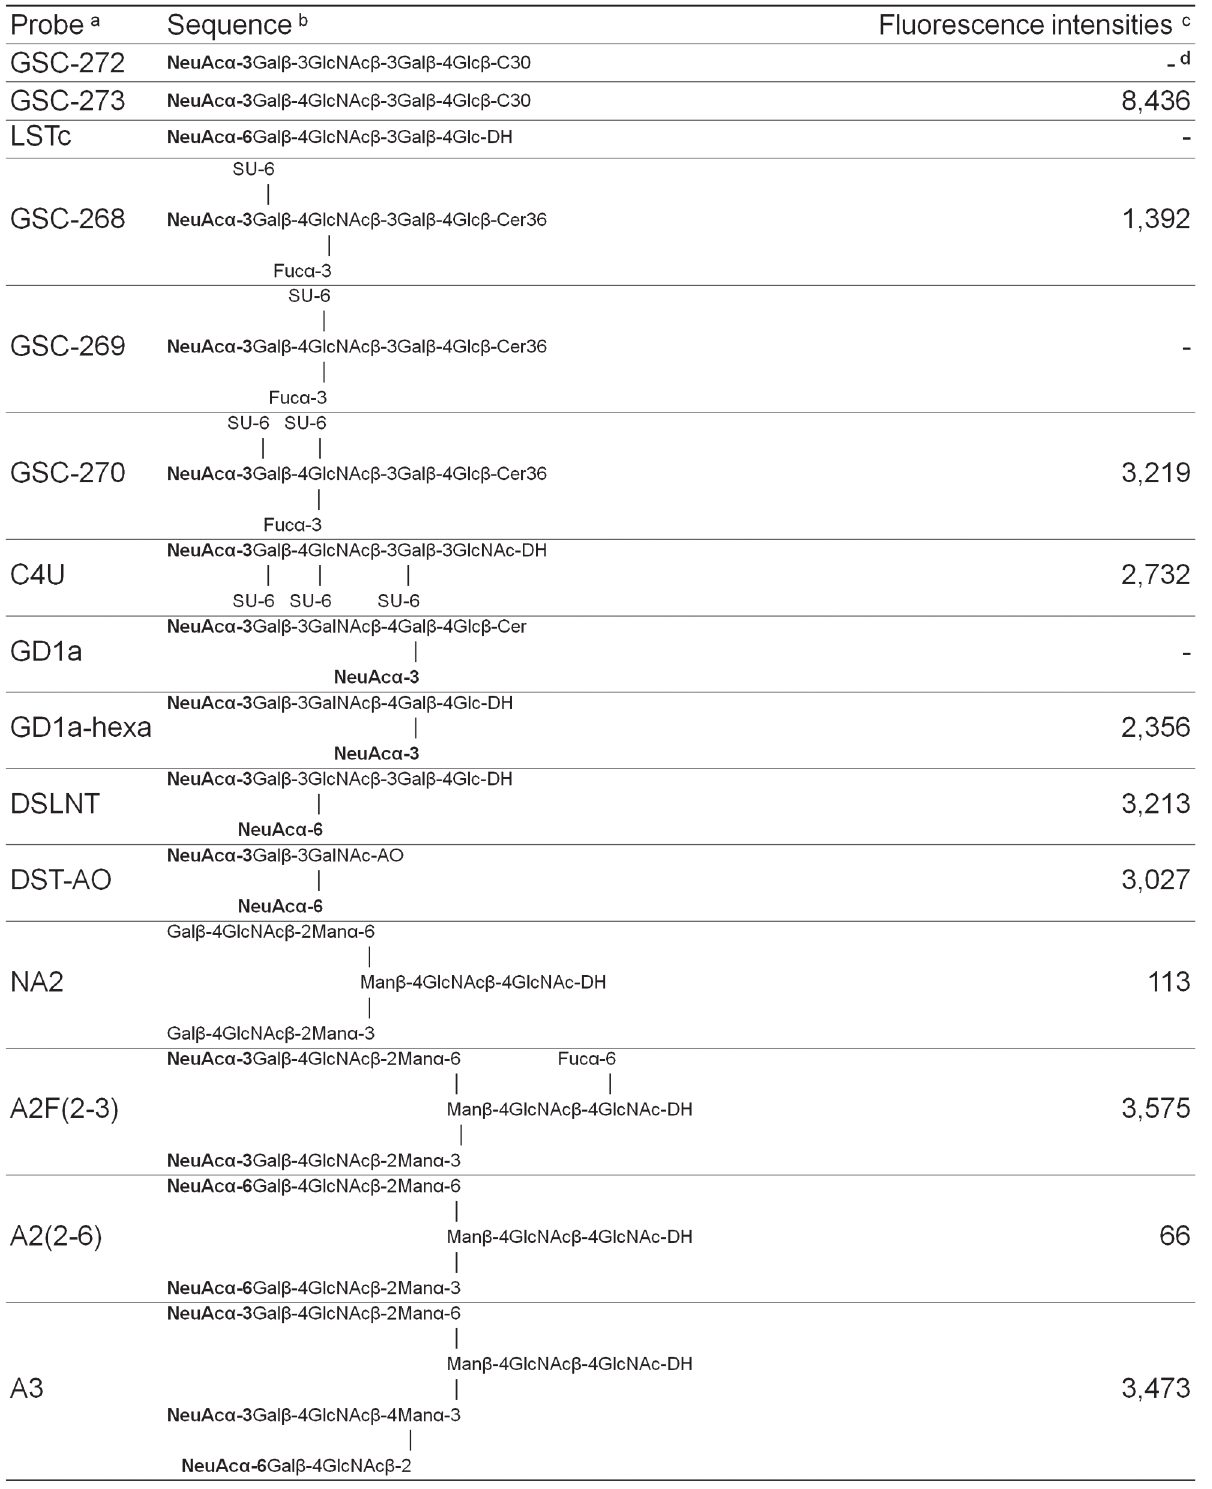
Fig 6. Features of 52SFK binding to selected sialyl sequences in the microarray. a The oligosaccharide probes are all lipid-linked, neoglycolipids (NGLs) or glycosylceramides and are from the collection assembled in the course of research in the Glycosciences Laboratory. b The selected α 2-3-linked and α 2-6-linked sialyl sequences are marked in bold . For definition of the lipid moieties of the probes, please see https://glycosciences.med.ic.ac.uk/docs/ lipids.pdf c Numerical scores for the binding signals are shown as means of duplicate spots at 5 fmol per spot. d -, signal less than